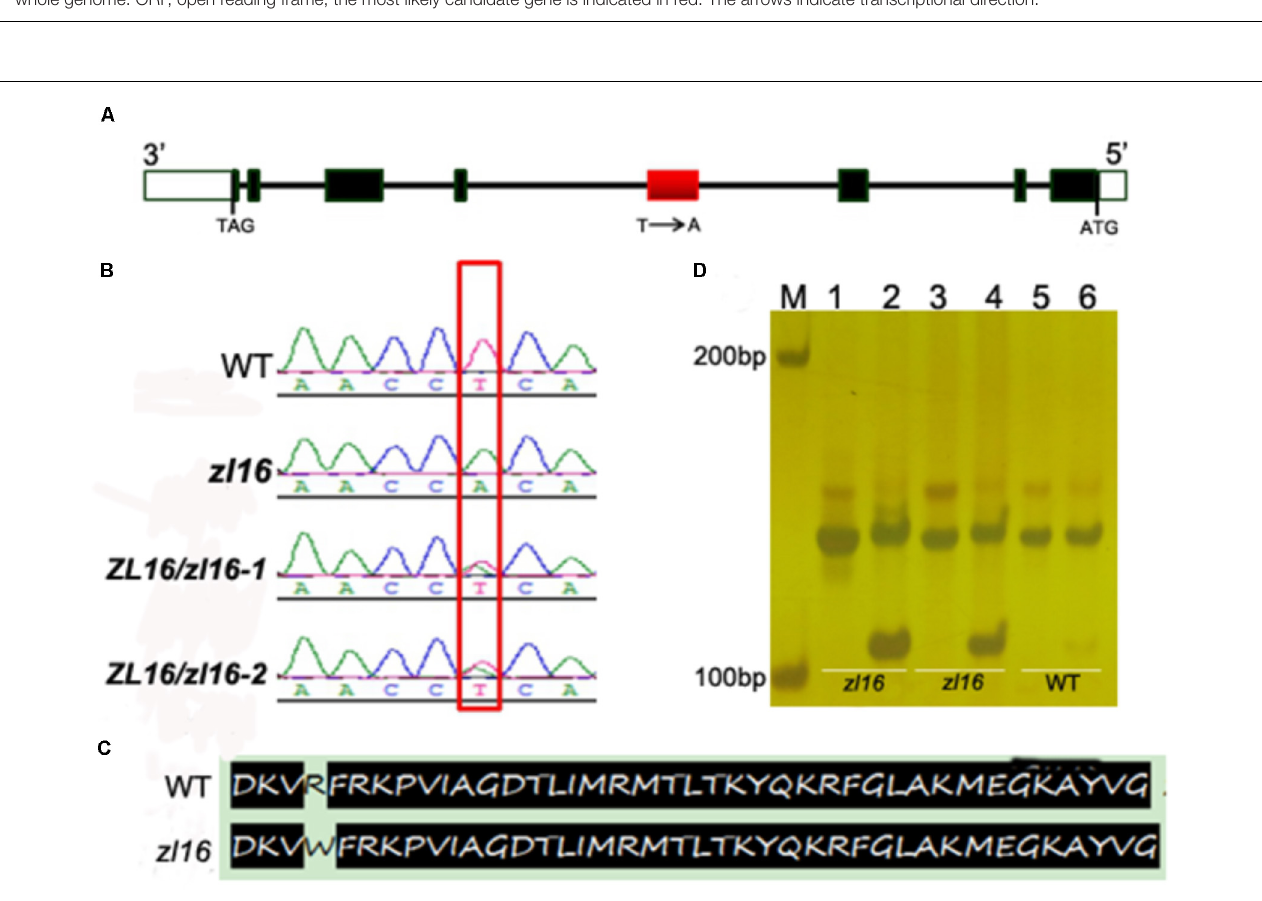
FIGURE 4 | Identification of the mutation site and structure of zl16. (A) The structure of ZL16 gene. ATG and TAG represent the start and stop codons, respectively. Black box indicates the exon and the line denotes intron. The region where base substitution happens is shown in red box. (B) cDNA sequence comparison between the wild type, homozygous zl16 mutant ( zl16/ zl16 ), and two heterozygous ( ZL16/ zl16- 1 and 2) genotypes. The point mutation was shown in box. (C) Comparison of translated protein sequences in the wild type (WT) and zl16 mutant. (D) Identification of the base substitution between wild type and zl16 with a dCAPs marker. Lane M means the molecular weight marker; Lanes 1, 3, and 5 indicate PCR products without Alu I digest; Lanes 2, 4, and 6, PCR products with Alu I digest. Lanes 1–4, DNA samples from the two homozygotes of the zl16 mutant. Lanes 5–6, DNA samples from the wild-type cultivar, 9311.